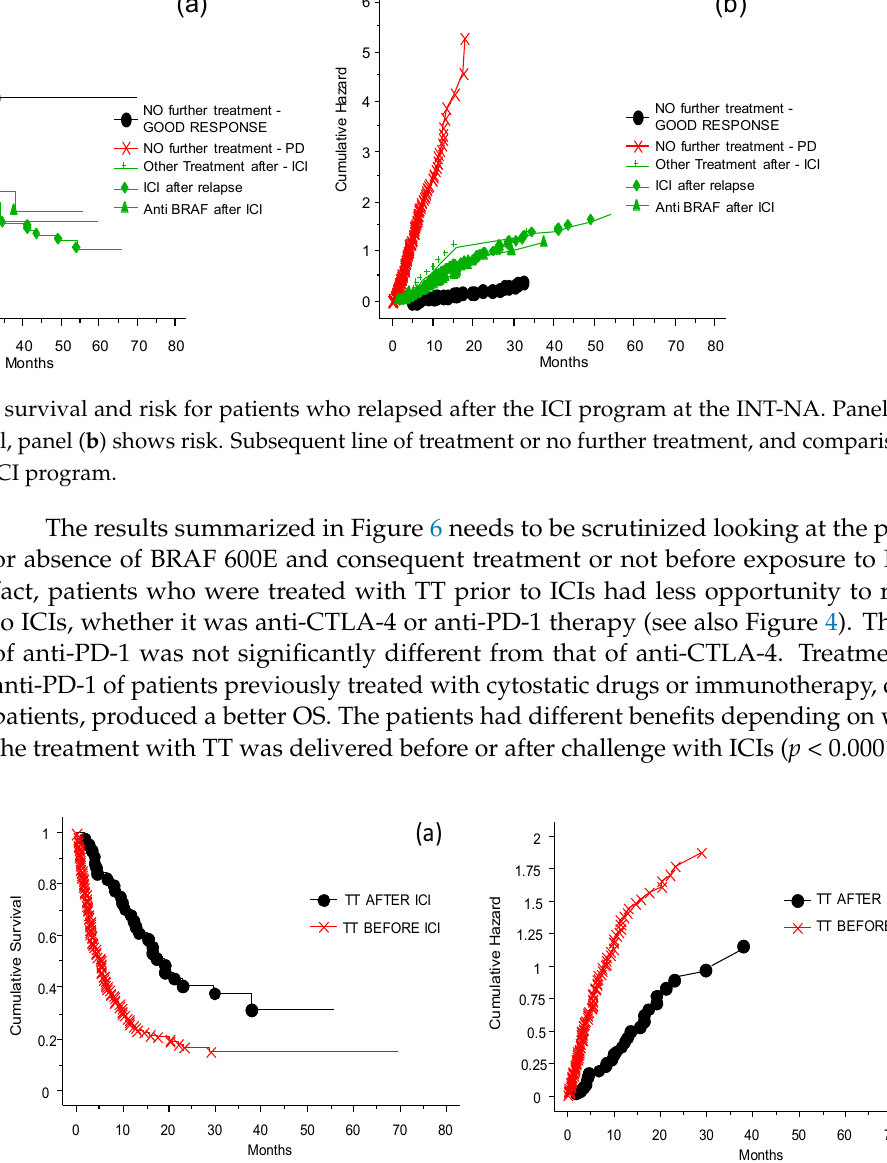
Figure 6. Probability of survival and risk for patients treated with TT before or after ICIs. Panel ( a ) shows probability of survival, panel ( b ) shows risk. The patients had different benefits depending on whether the treatment with TT was delivered before (worst OS, red line) or after (better OS, black line) the challenge with ICIs in case of disease progression ( p < 0.0001).